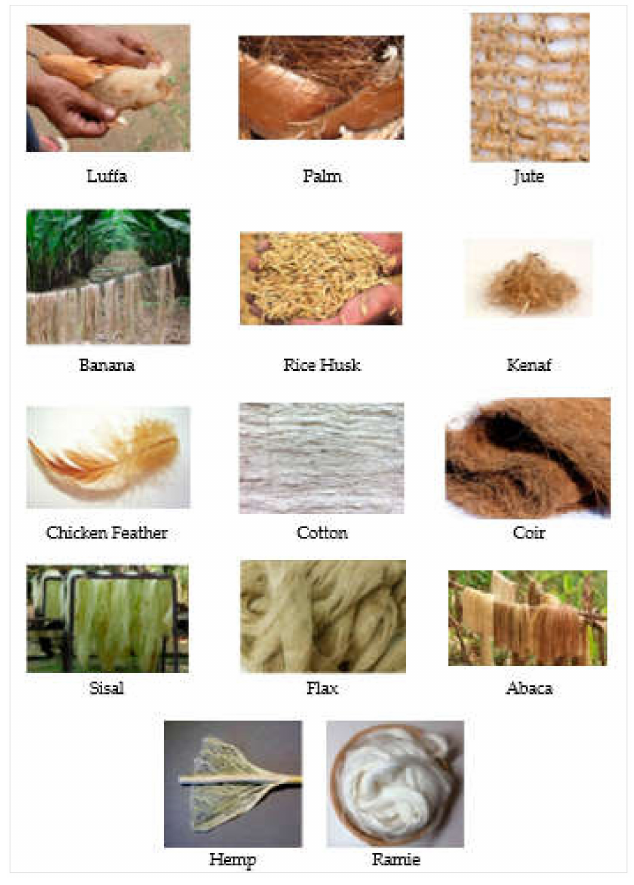
Figure 3. Natural fibers